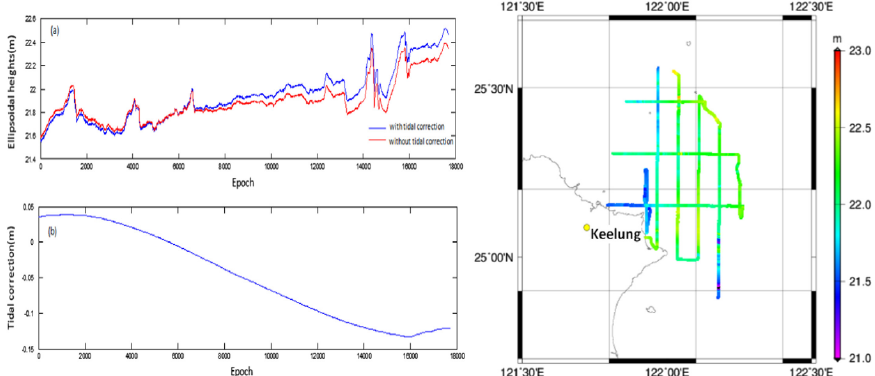
Figure 10. (Left) Ocean tidal corrections of PPP ellipsoidal heights after Gaussian filtering. ( a ) ellipsoidal heights, ( b ) tidal corrections. (Right) SSHs along ship tracks [13].